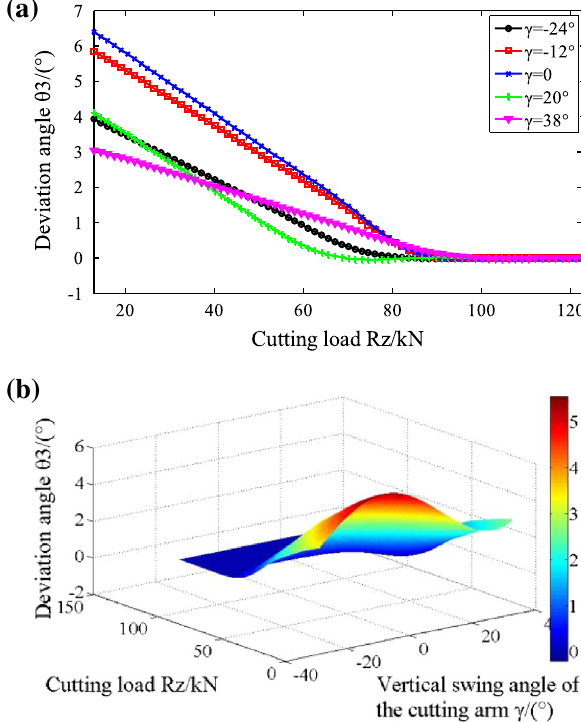
Fig. 14 Response regularities of the roll angle during the vertical cutting process. ( a ) Relationship between the roll angle and the cutting load; ( b ) Relationship of the roll angle, cutting load and ver- tical swing angle of the cutting arm